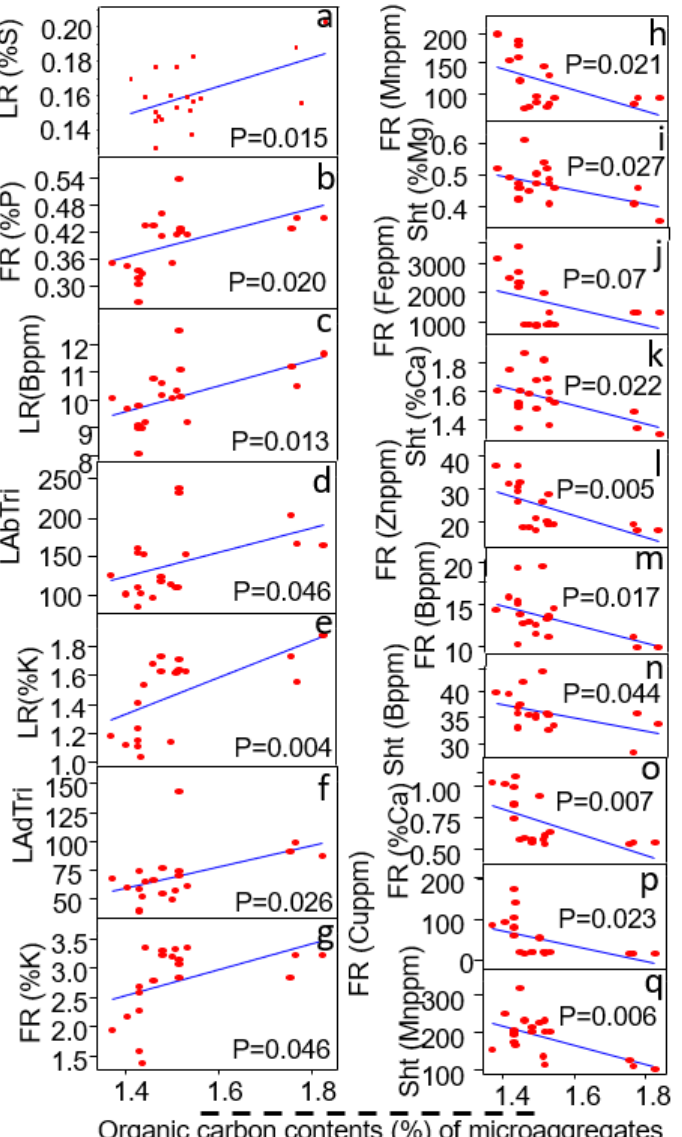
Figure 6. The relationship of organic carbon contents (%OC) of soil microaggregates to plant traits as determined by linear regression. The abbreviations are LR (large roots), FR (fine roots), Sht (shoot), LAdTri (leaf adaxial trichome density), and LAbTri (leaf abaxial trichome density). The trichome density was number of trichomes per 0.29 cm 2 of soybean leaf area. Only significant ( p < 0.05 ) relationships are plotted ( a – q ).